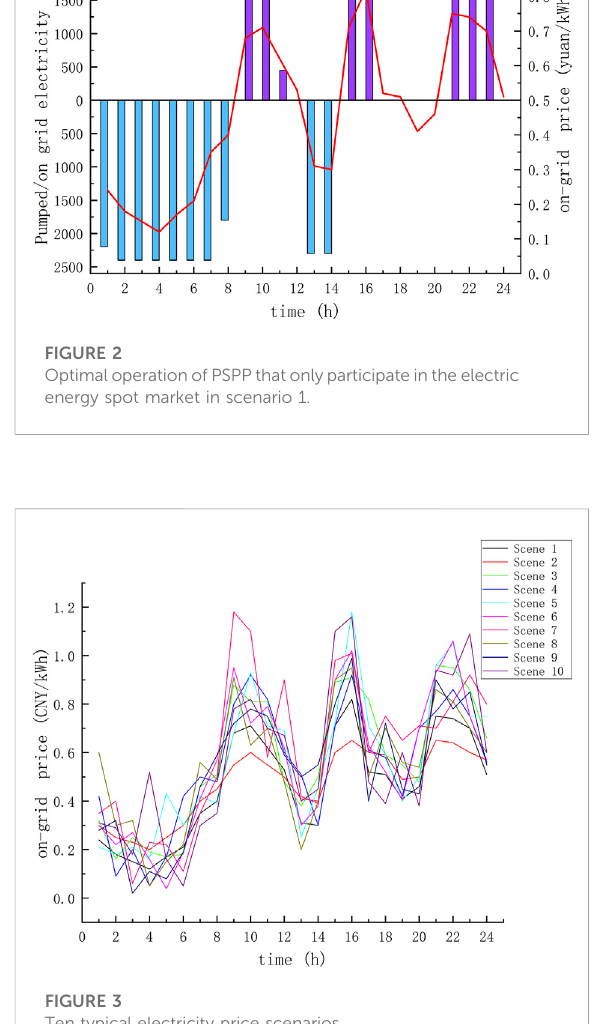
FIGURE 3 Ten typical electricity price scenarios.